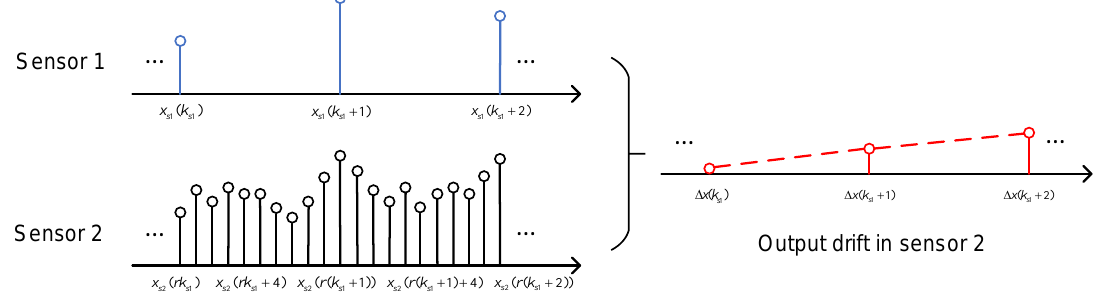
Figure 2. Illustration of the drift-state estimation process.